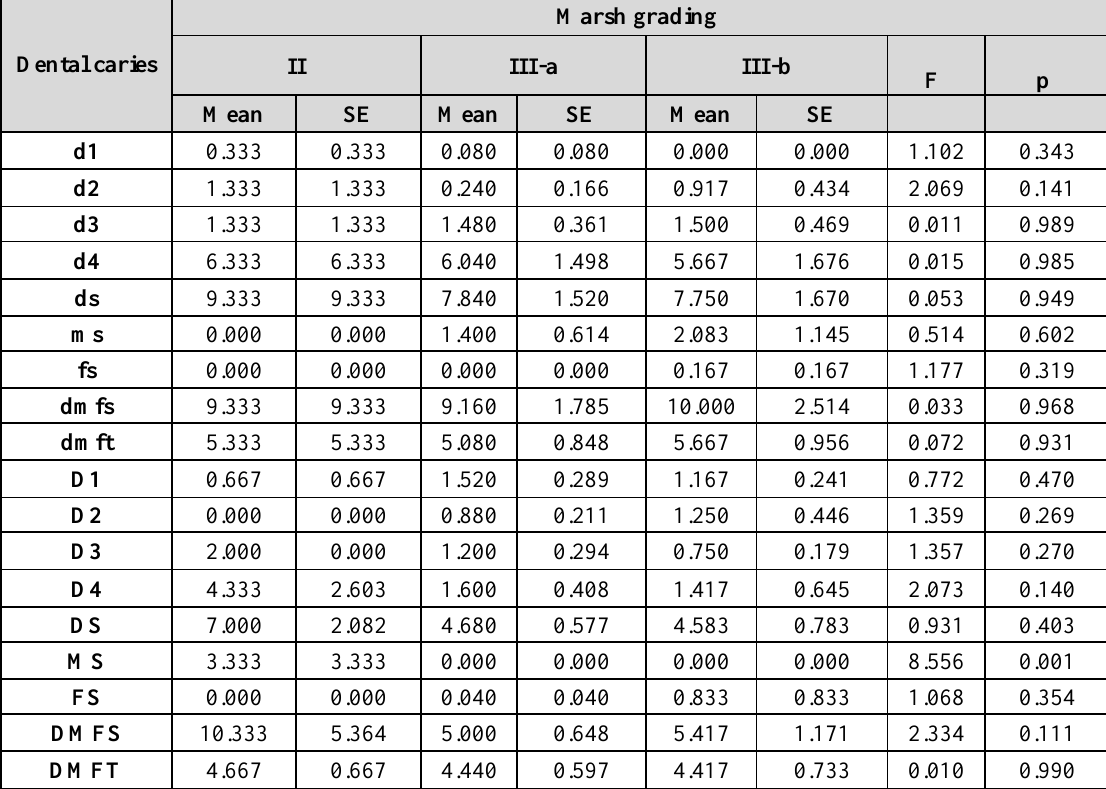
Table 3: Dental caries experience and severity for primary and permanent teeth according to Marsh